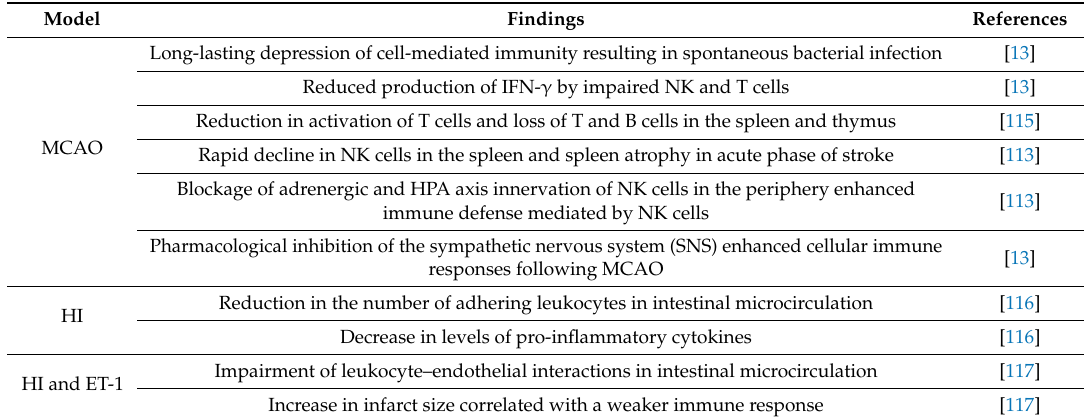
Table 1. Summary of peripheral immune responses to di ff erent experimental stroke